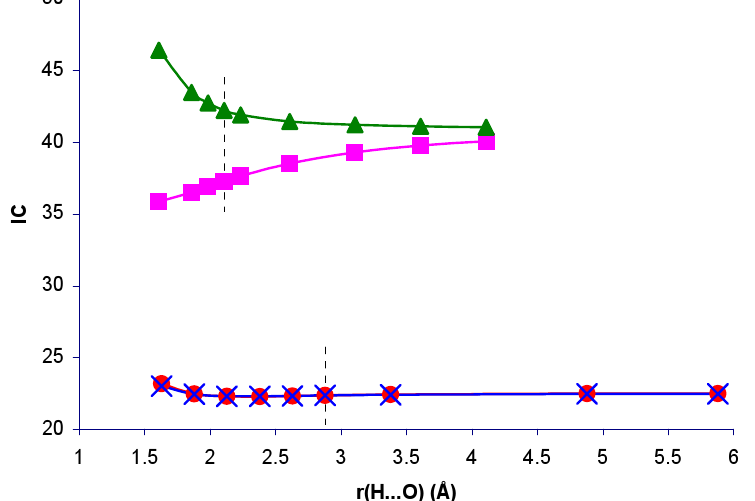
and CH ...OH complexes, and in the 2 4 2 molecules with the complex geometry, as a function of the H...O distance, 4 ), - × - IC (CH ...OH ), - (cid:86) - IC (NCH), - (cid:79) - IC (CH ). The dotted lines 2 4 2 4